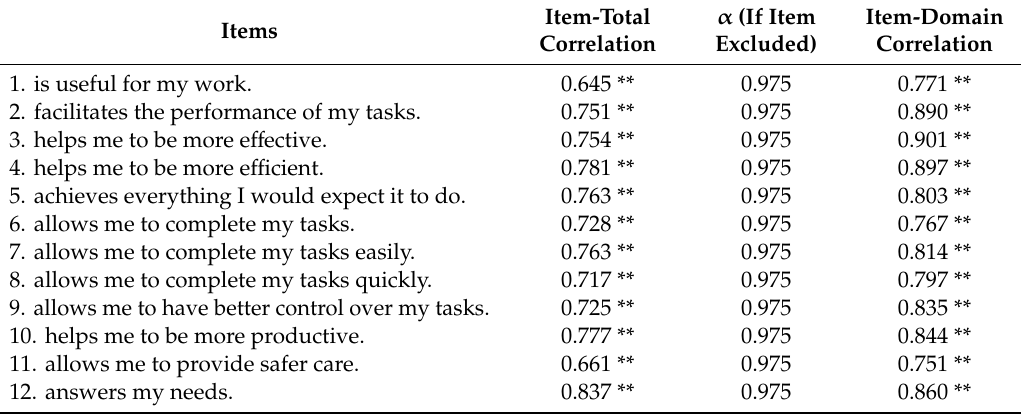
Table 2. Usefulness items (The use of a double-chamber syringe for intravenous